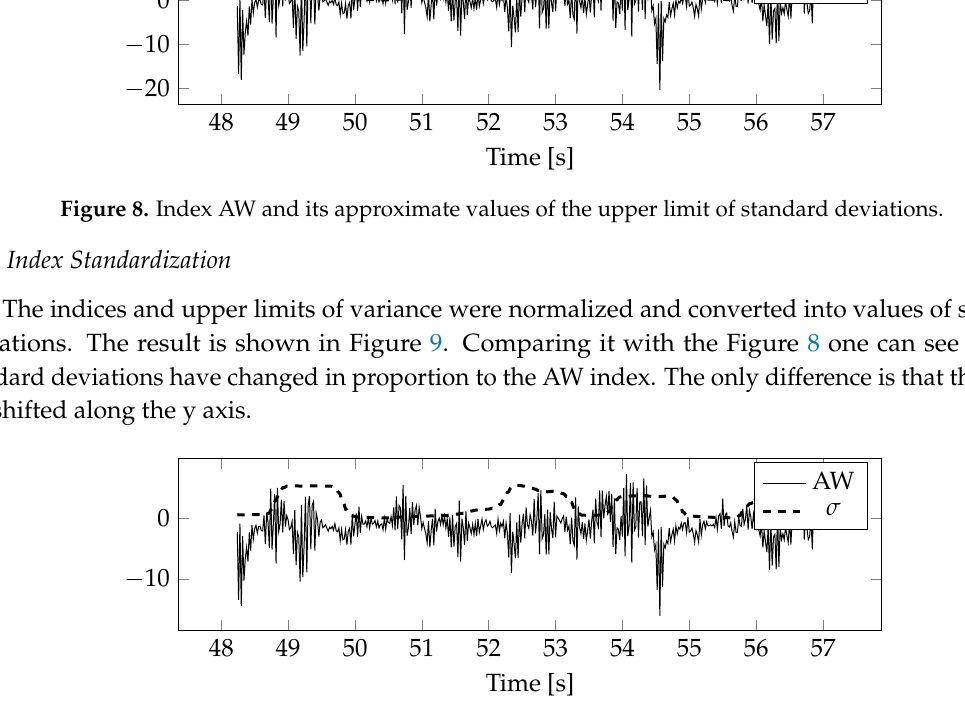
Figure 9. Standardized index AW and its approximate values of the upper limit of standard